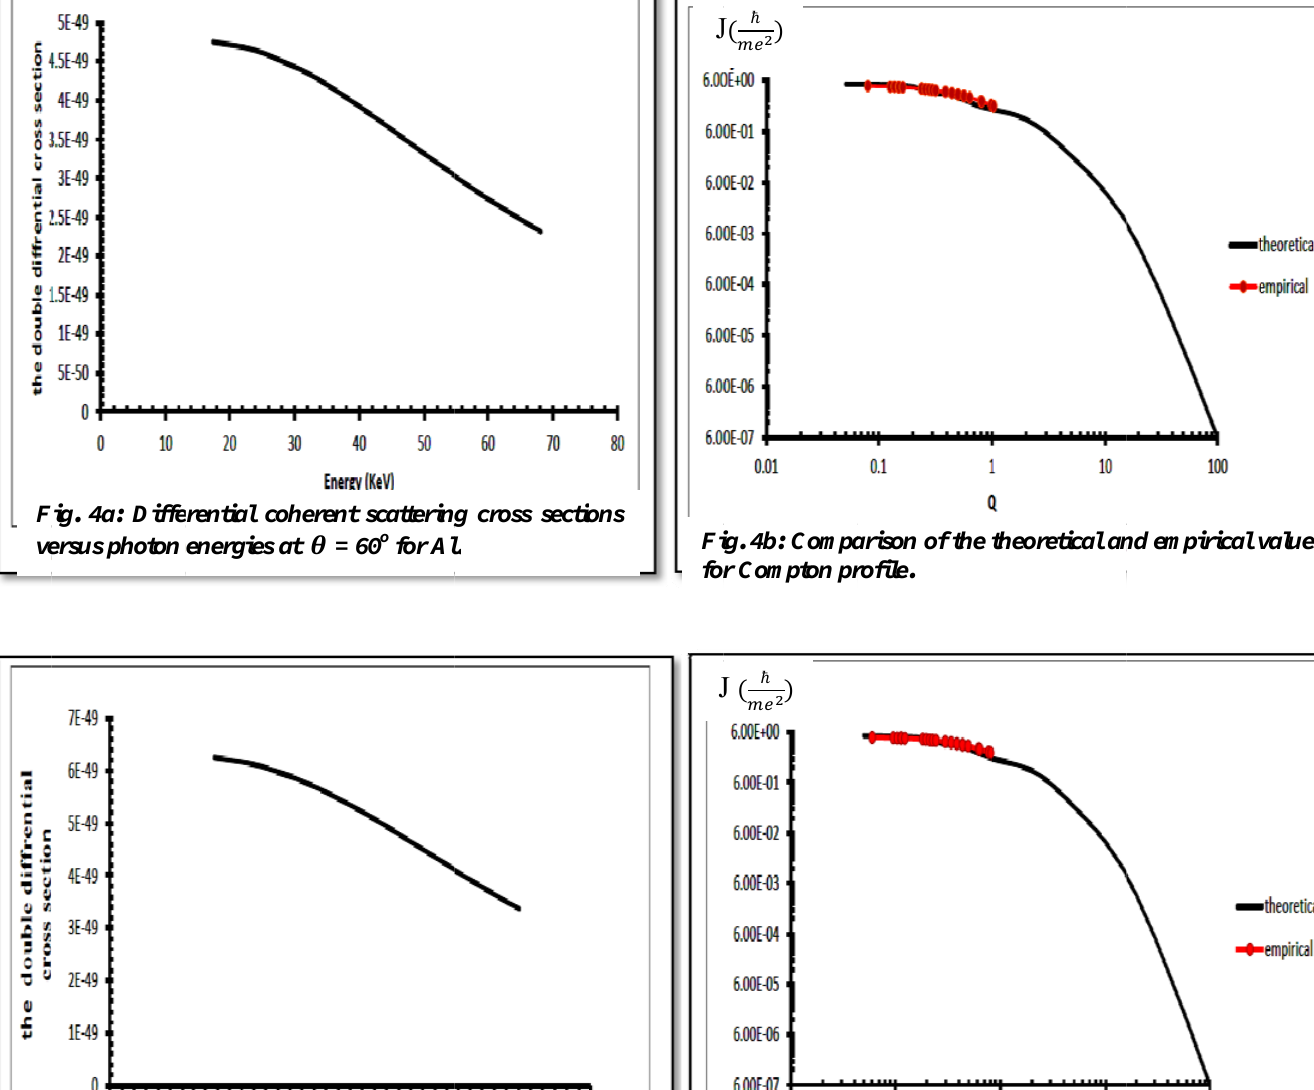
ections Fig. 5b: Com